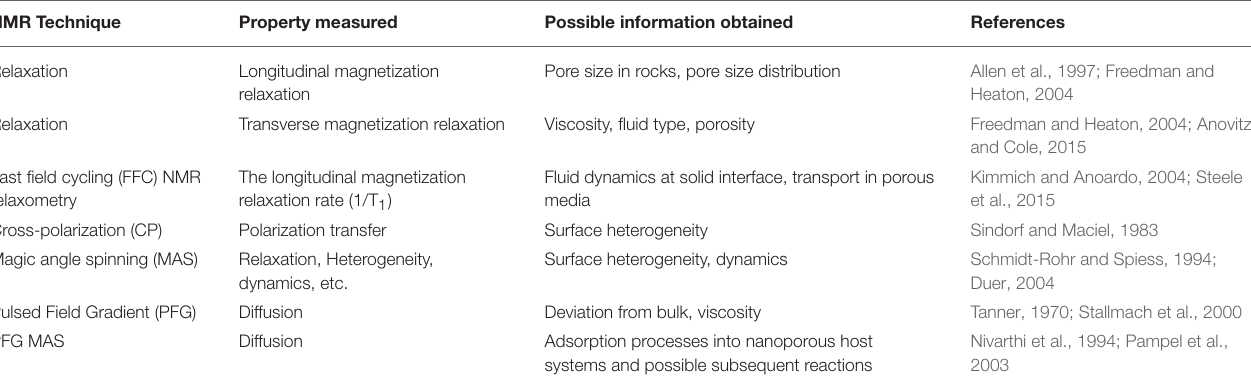
TABLE 2 | Summary of NMR techniques commonly applied in geologically relevant porous